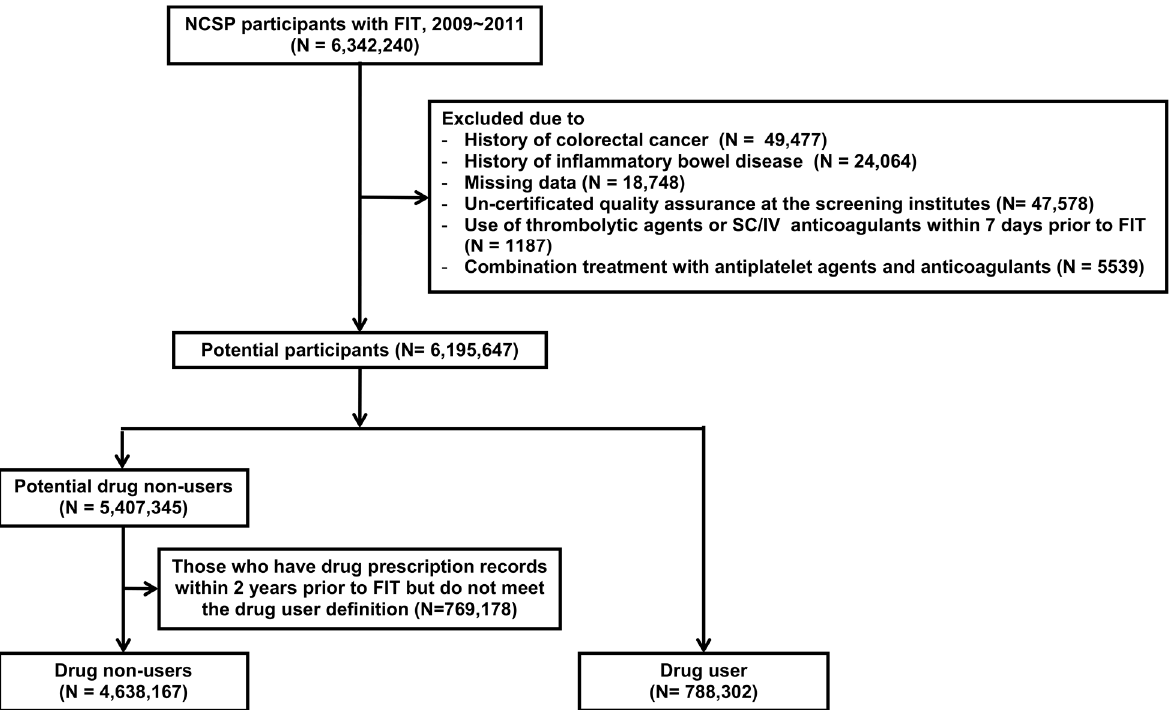
Figure 1. Flowchart of the study population. FIT, fecal immunochemical test; SC/IV, subcutaneous/intravenous.